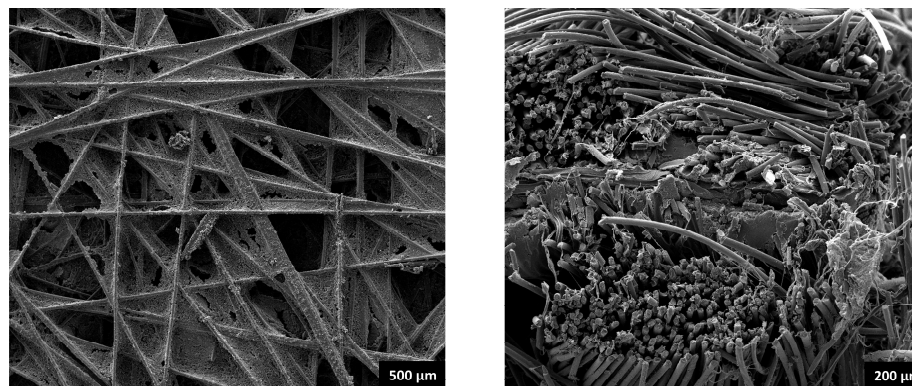
Figure 1. Surface view ( left ) and cross-sectional view ( right ) of a carbon paper